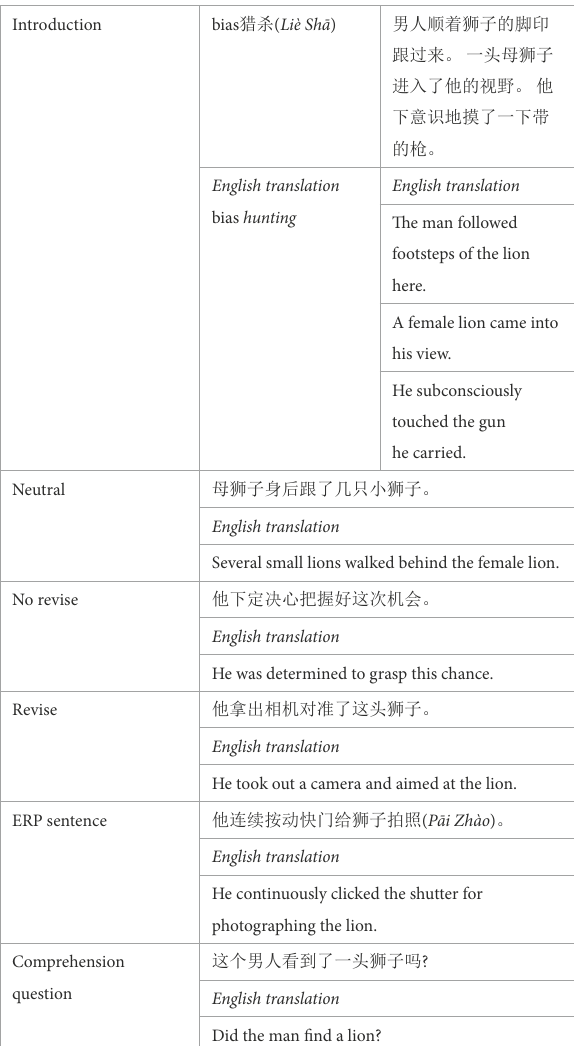
TABLE 1 Sample material used in Experiment